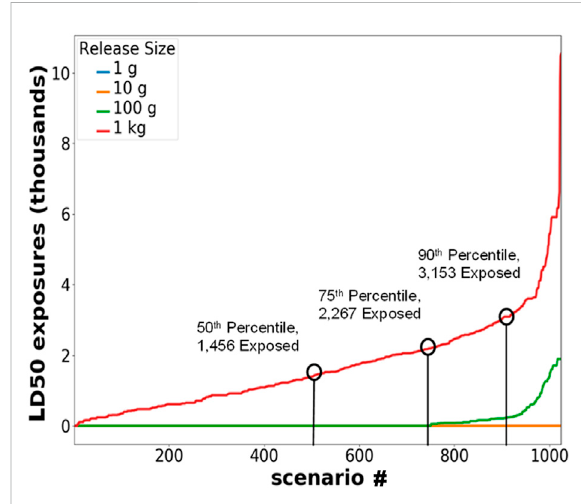
FIGURE 2 Example percentile calculation. Abrin LD 50 exposures for 1,024simulatedreleasesinFacility1,orderedfromleasttogreatest number of LD 50